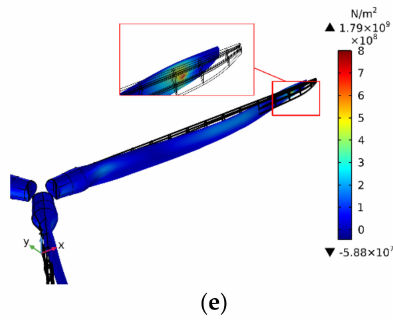
Figure 9. Blade stress distribution at wind speed of 60m/s: ( a ) blade without RCC; ( b ) blade with RCC connected at one − third of the blade length; ( c ) blade with RCC connected at half of the blade length; ( d ) blade with RCC connected at two-thirds of the blade length; ( e ) blade with RCC connected at the blade tip.